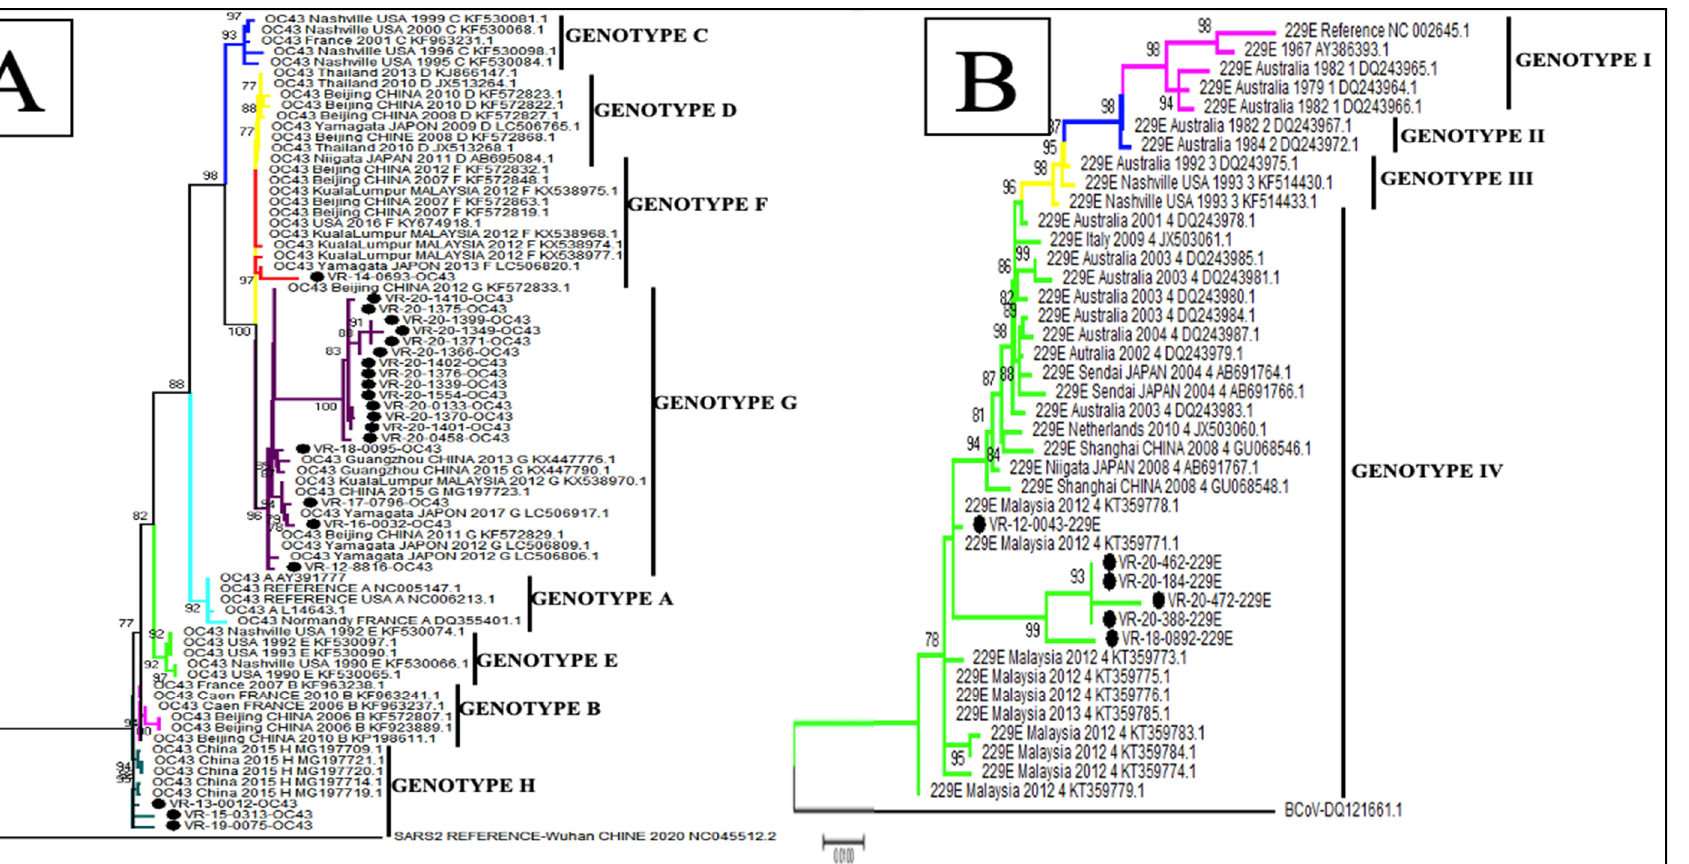
Figure 3. Phylogenetic analyses of HCoV-OC43 ( A ) and HCoV-229E ( B ) strains detected in patients with ILI/SARI, between 2012 to 2020, in Senegal. The phylogenetic trees are based on nucleotide sequences of the spike protein gene generated using the maximum likelihood tree with the Tamura–Nei evolutionary model, as implemented in MEGA 7 software. One thousand bootstrap replicates were performed to determine the consensus tree presented in this figure, and support for the nodes present in greater than 70% of the trees are annotated. Senegalese strains are represented in black dots.